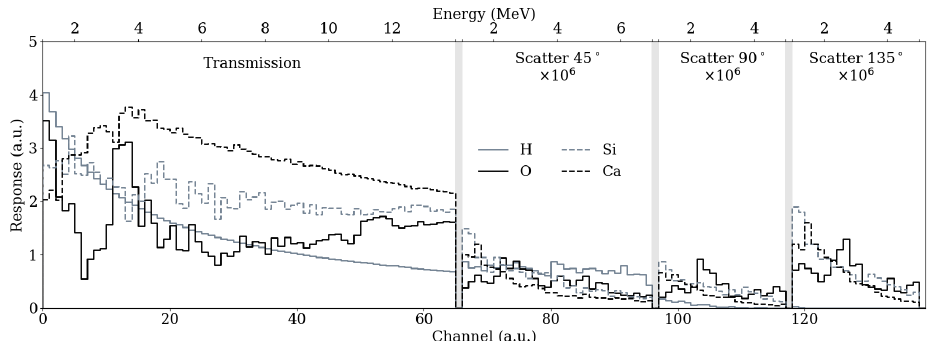
Fig. 3. Response functions constructed for elemental samples of hydrogen, oxygen, silicon and calcium. Effective removal cross sections are used between 1.0 MeV and 14.0 MeV for the transmission component. The scattered components consist of the simulated energy spectra between 1.0 MeV and 7.0 MeV for 45 ° , and 1.0 MeV and 5.0 MeV for 90 ° and 135 ° . For convenience the scattered fluence spectra have been multiplied by a factor of 10 6 .